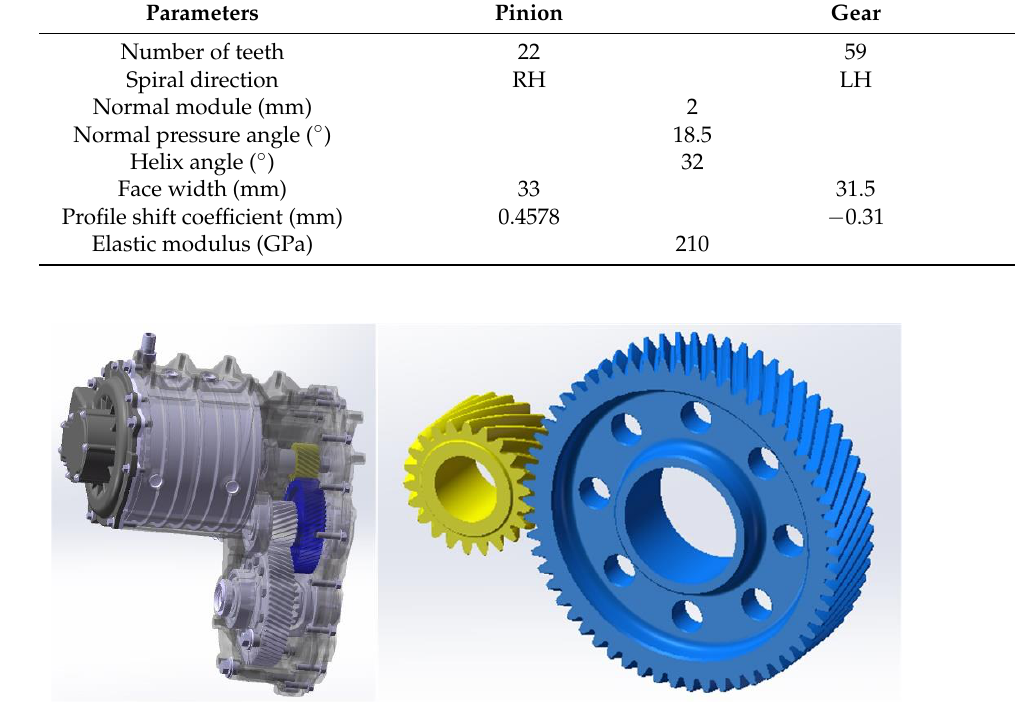
Table 2. Basic parameters of the gear pair.